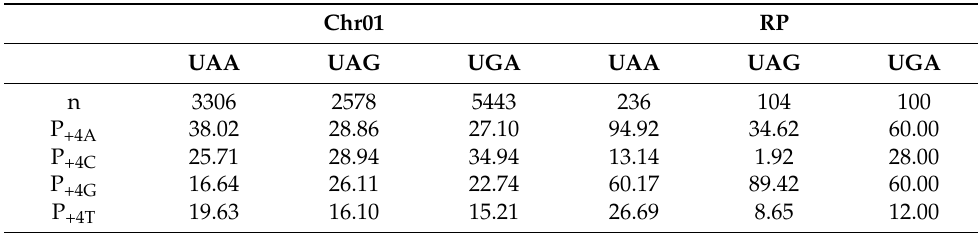
Table 7. Contrasts between highly expressed ribosomal protein genes (RP) and all CDSs in human chromosome 1 (Chr01, including isoforms). Shown are the total number of individual stop codons (n) and the percentage of +4A, +4C, +4G, and +4U (P +4A , P +4C , P +4G , and P +4U ) for CDSs terminating with UAA, UAG and UGA. Chr01 RP UAA UAG